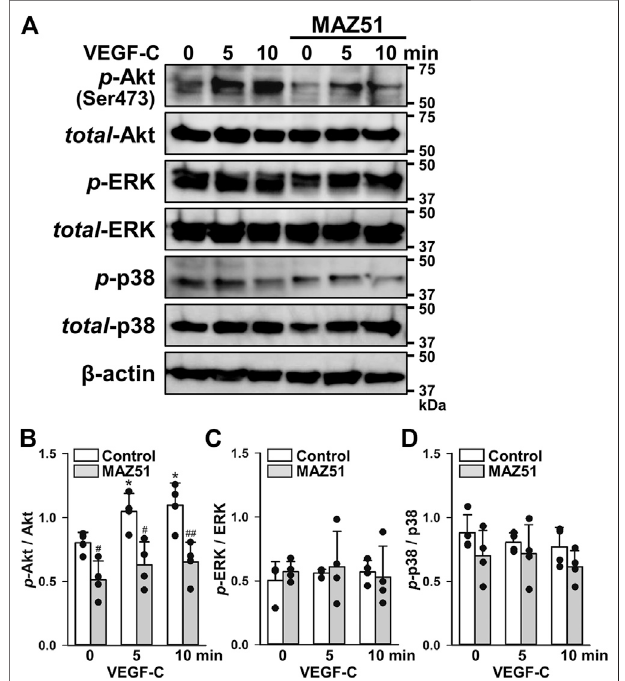
FIGURE 4 | Phosphorylation pathway following VEGF-C-induced VEGFR-3 activation. The phosphorylation signaling after VEGF-C-induced VEGFR-3 activation was assayed in the absence and presence of MAZ51 in human prostate cancer PC-3 cells by Western blotting. (A) Representative blots of phosphorylation of Akt (Ser473), ERK1/2, and p38 after 50 ng/ml VEGF-C stimulation in the absence and presence of 3 μ M MAZ51 for 4 h in PC-3 cells. (B – D) The phosphorylation level of Akt (B) , ERK1/2 (C) , and p38 (D) by the VEGF-C stimulation in the absence and presence of MAZ51 in PC-3 cells ( n (cid:1) 4). Data are presented as means ± S.D. * p < 0.05 vs. 0 min; # p < 0.05, ## p < 0.01 vs. control (unpaired two-tailed t